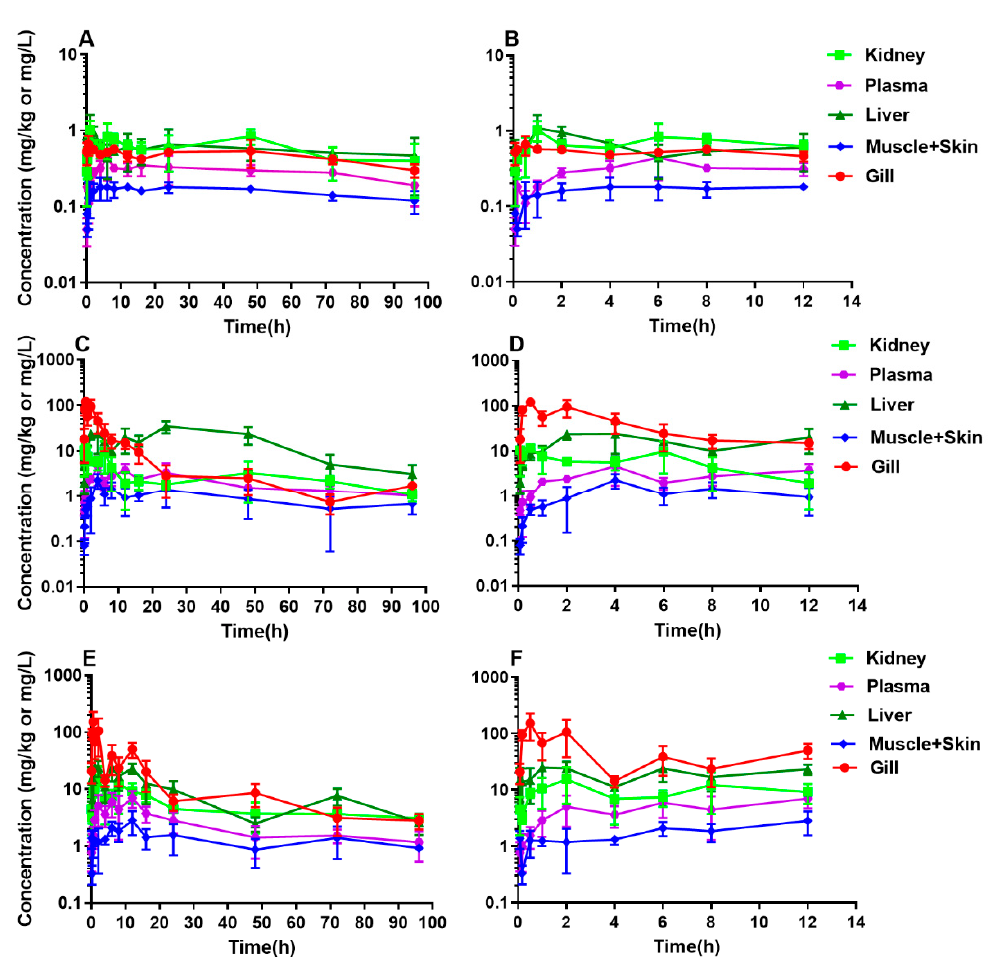
Figure 1. Semi-logarithmic plots of plasma and tissue concentration-time profiles of doxycycline in yellow catfish ( Pelteoba- grus fulvidraco ) following an oral dose at 10 ( A , B ), 20 ( C , D ), or 40 mg/kg ( E , F ) at 24 ◦ C. A , C , and E : For all sampling time points; B , D , and F : For a part of the sampling points from 0.083 to 12 h. Sample size: n = 6.